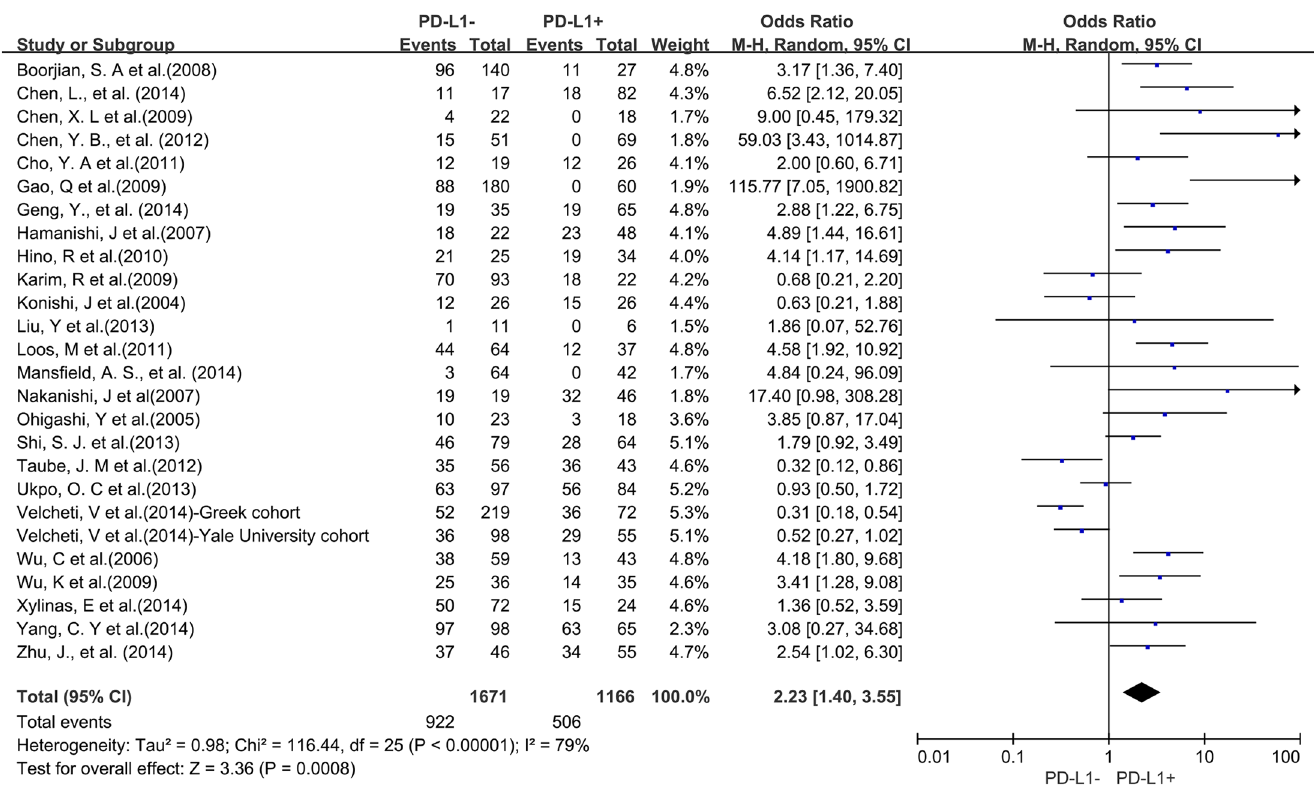
Fig 4. Forest plot describing the association between PD-L1 expression and 5-year OS of all patients with solid tumors.